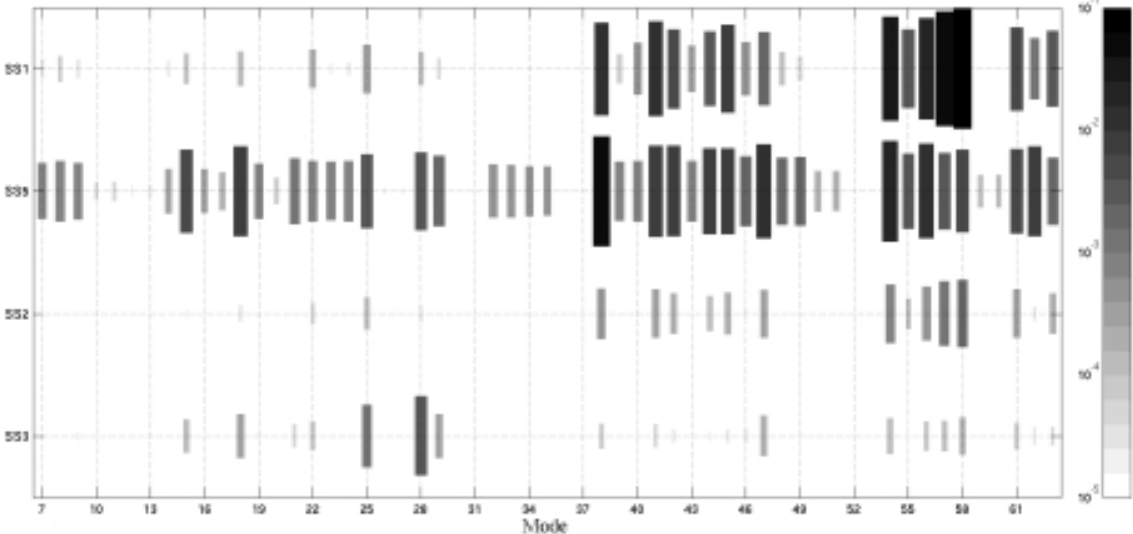
Fig. 13. Superelement error localization after severe